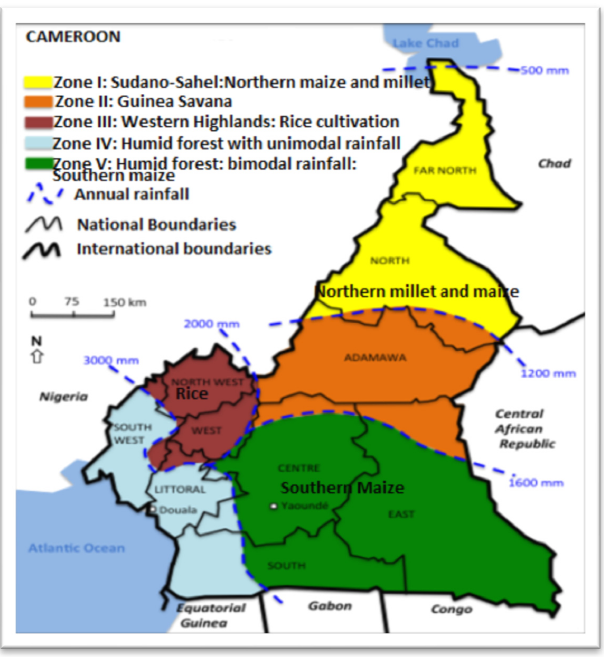
Figure 2. Agroecological Zones of Cameroon.